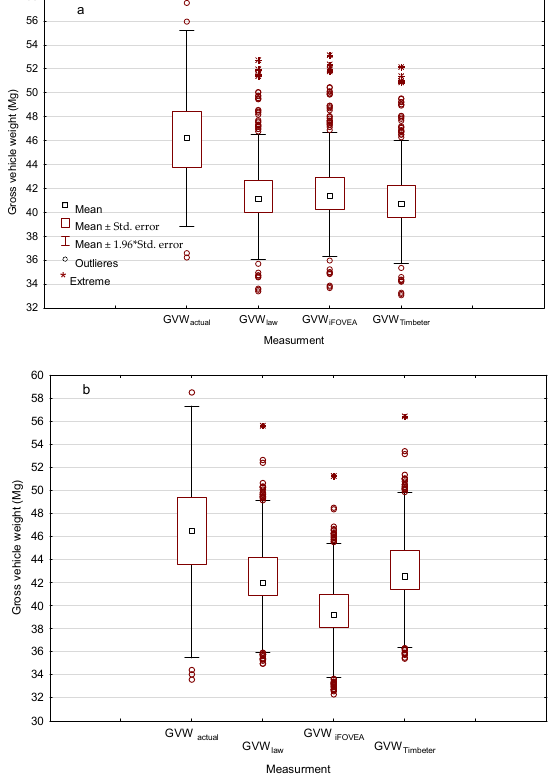
Figure 9. Comparison of the real total gross vehicle weight of the transport sets for S2 wood loads with the wood volumes of: ( a ) broadleaf wood and ( b ) coniferous wood, as determined by the legislation and the measurement method.